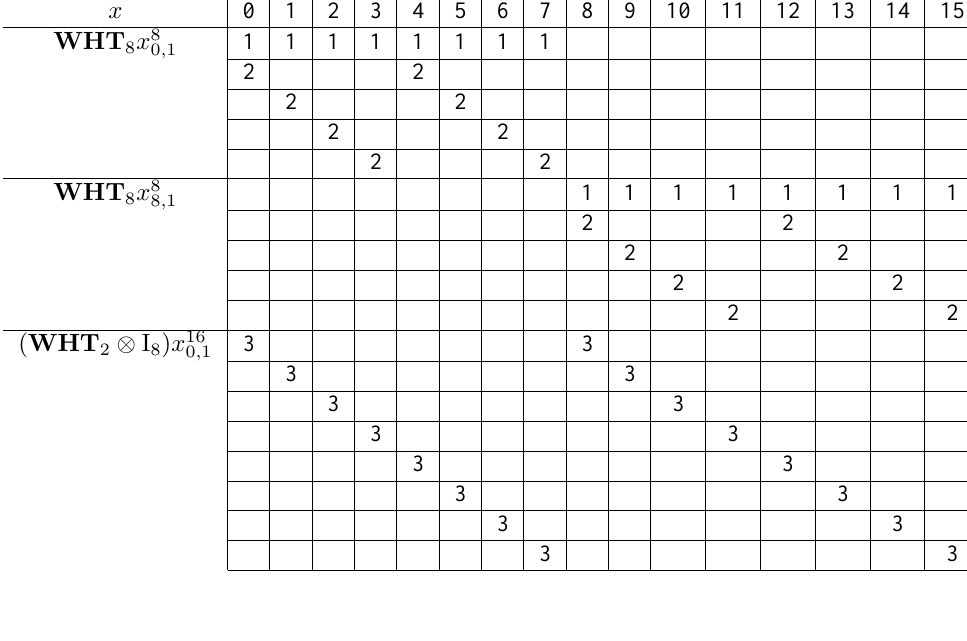
Tab. 2: Memory Access Pattern for Algorithm (b) in Figure 3